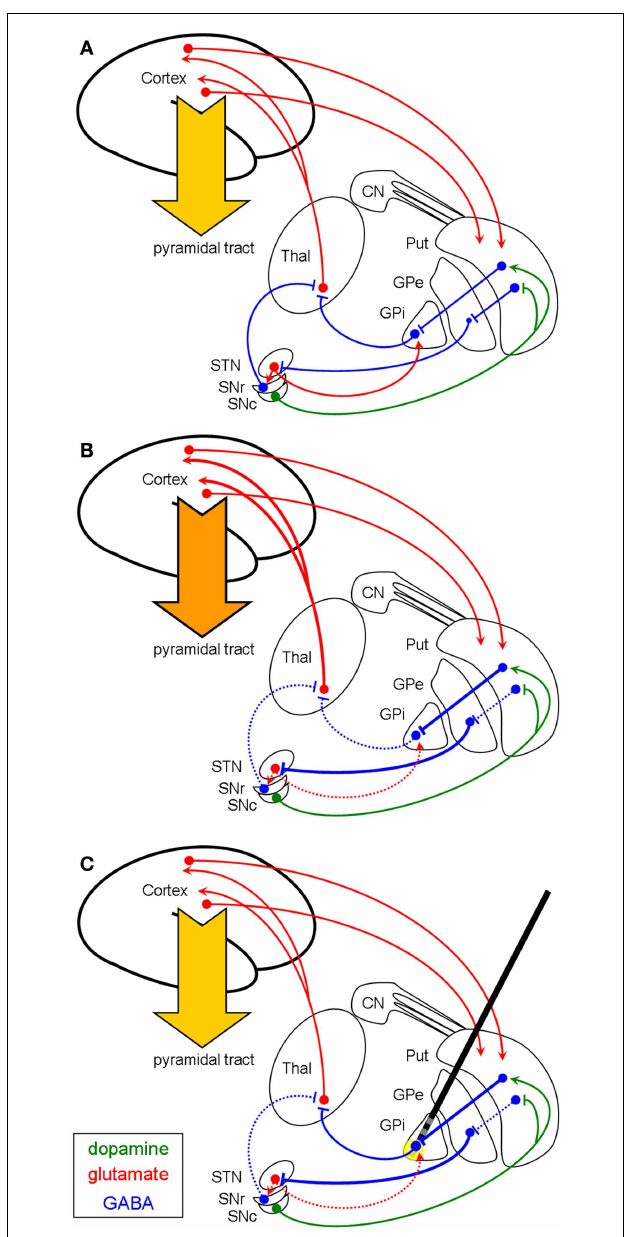
FIGURE 1 | Schematic illustration (coronar view) of the proposed basal ganglia network in a healthy condition (A) and in dystonia (B,C) . In this context it is not yet established, if for the direct pathways the striato-pallidal efferents are overactive or if the indirect pathway (from Put to GPe) is reduced. (B) depicts both possibilities resulting in a reduced inhibition of the thalamus, leading to a hyperkinetic dystonic disorder. Following the GABAergic hypothesis, pallidal HFS [ (C) , yellow circle] would result in a normalized thalamic inhibition via increased GABAergic outflow and therefore shows efficacy in reducing this hyperkinetic disorder (see also Discussion).Thal, thalamus; STN, subthalamic nucleus; SNr/c, substantia nigra pars reticularis/compacta; GPi/e, globus pallidus internus/externus; Put, putamen; CN, caudate nucleus; Arrowheads (green for dopamine, red for glutamate) reflect excitation; bars reflect inhibition (green for dopamine, blue for GABA). Pyramidal tract: dark orange arrow = hyperkinetic movement, light orange arrow = normokinetic